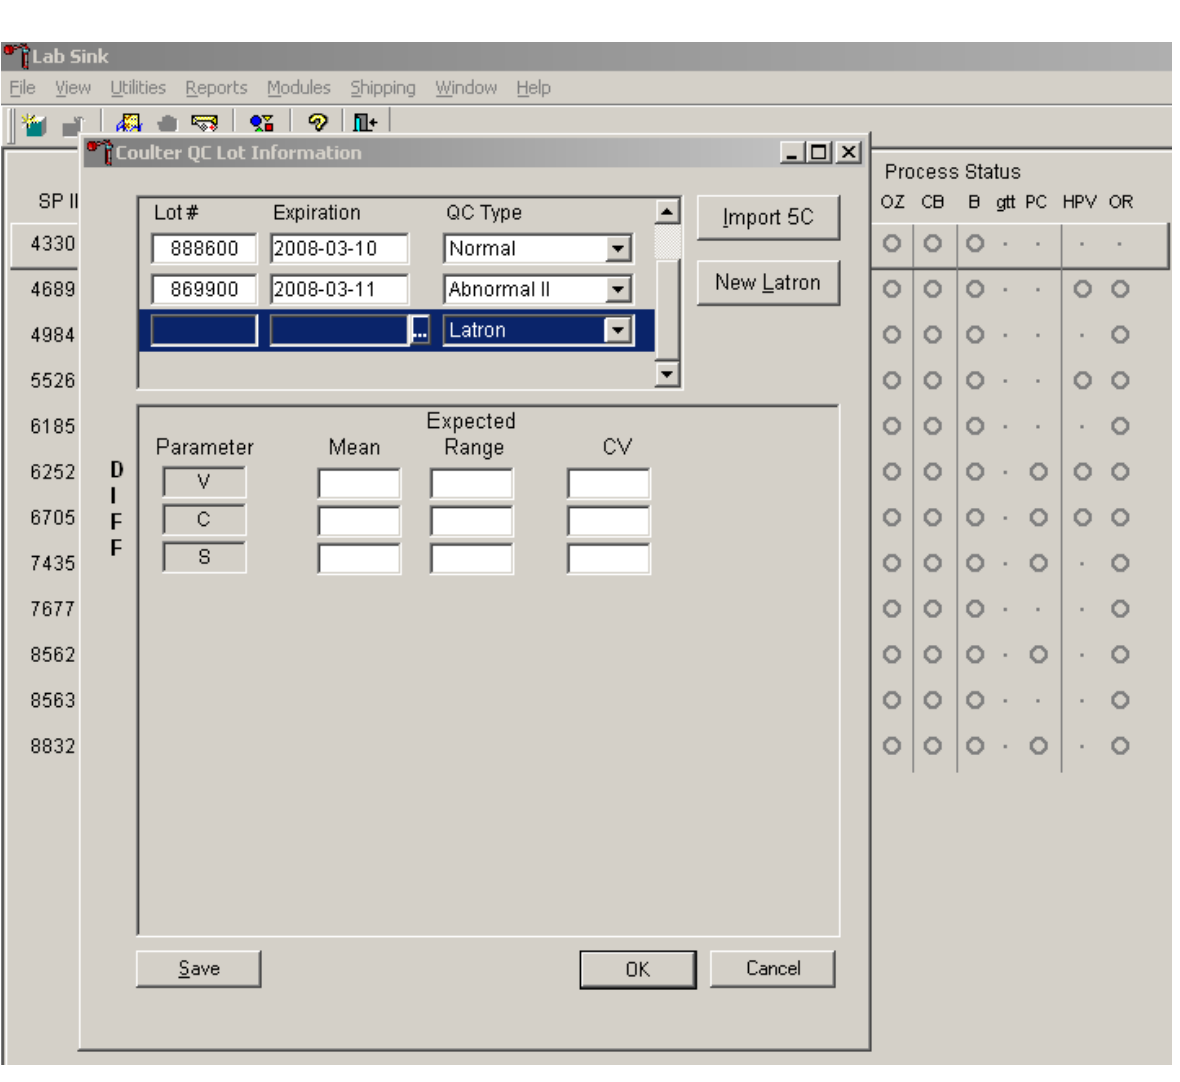
scroll bar to view the